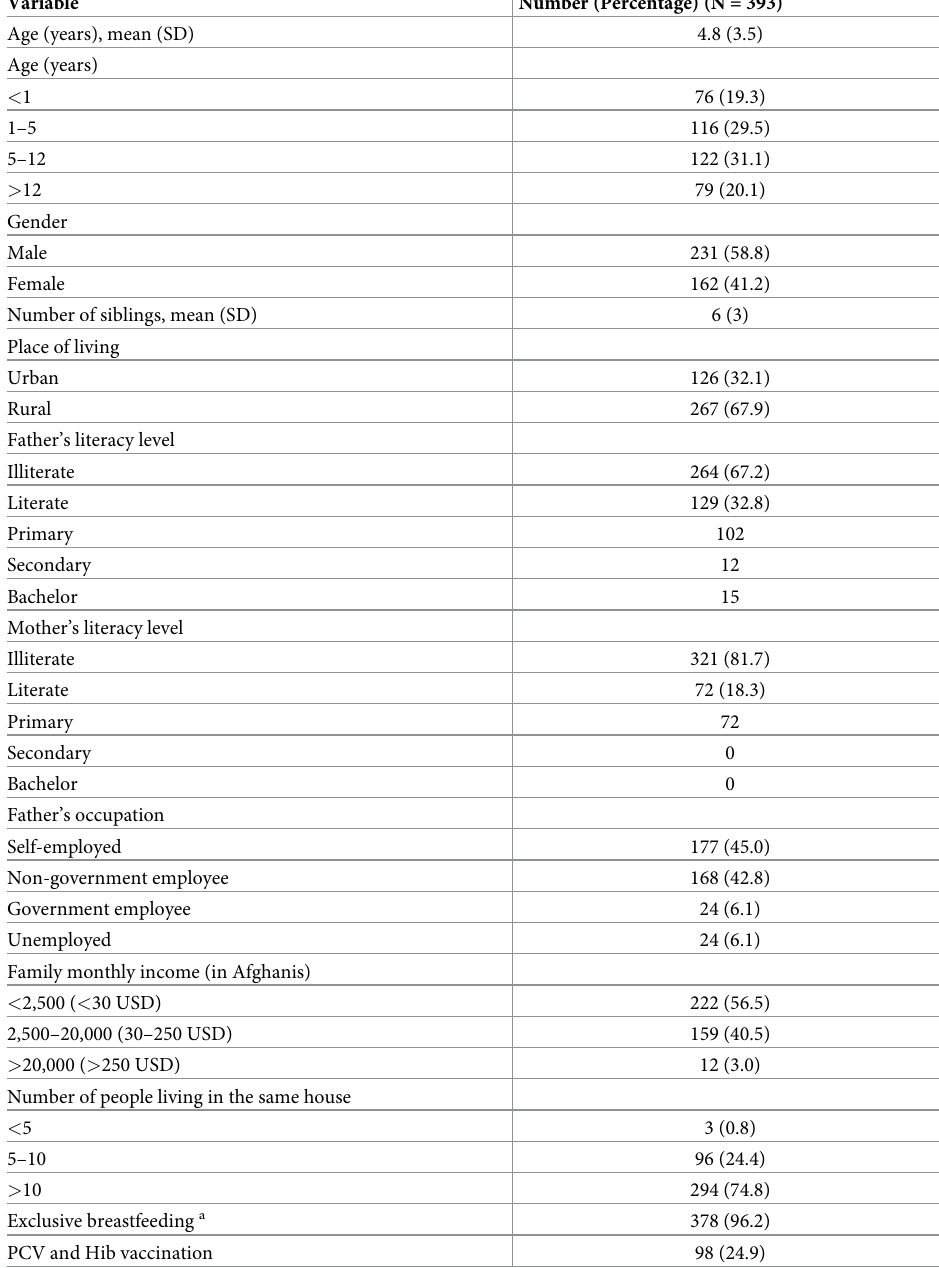
Table 1. Baseline socio-demographic characteristics and vaccination data of ABM